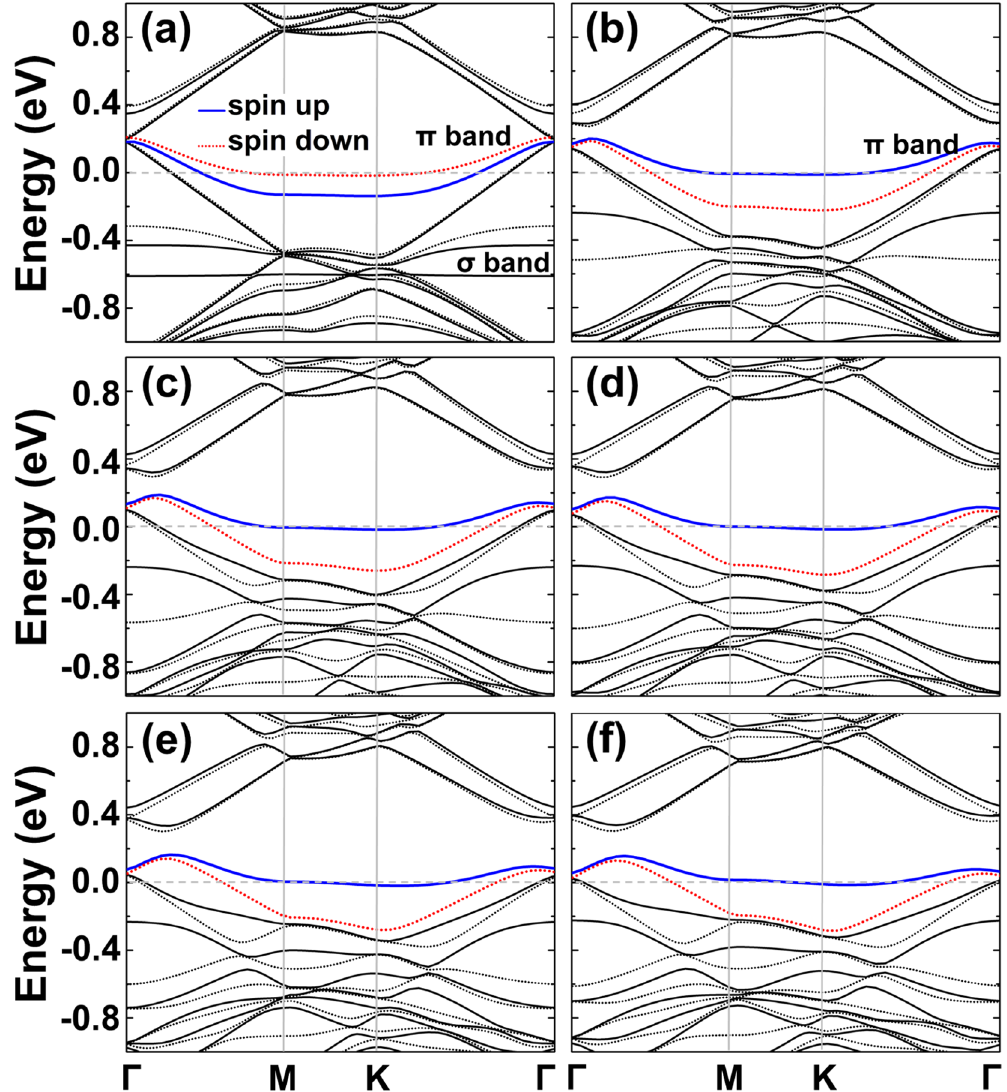
Figure 4. Band structures of the monovacancy in the 12 × 12 supercell. ( a )–( f ) At Δ θ = 0°–5°, respectively. Here, ( a ) Δ θ = 0° and ( b ) Δ θ = 1° correspond to the two magnetic states near the transition